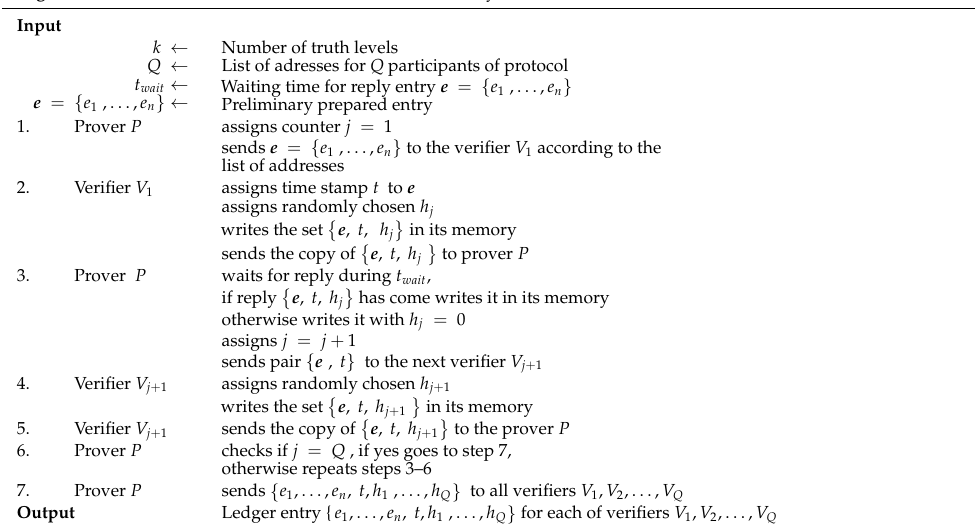
Algorithm 1 : Collective accumulation of hash values for